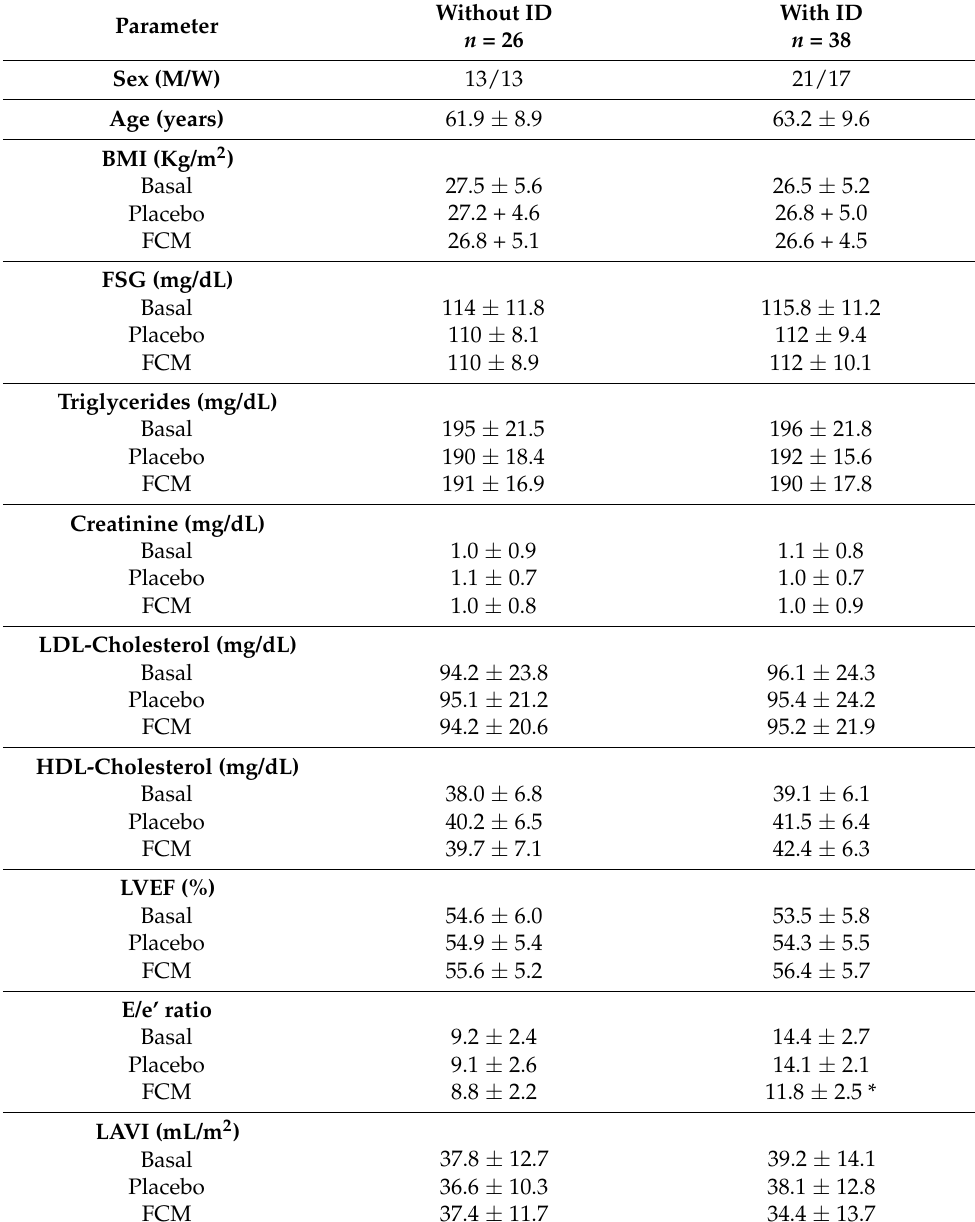
Table 2. Basal levels of principal biomarkers of metabolic balance and the demographics of patients with HFpEF (either with or without ID) enrolled in the study. Table also shows data on the effect of treatment with placebo and FCM. Without ID With ID Parameter n = 26 n =